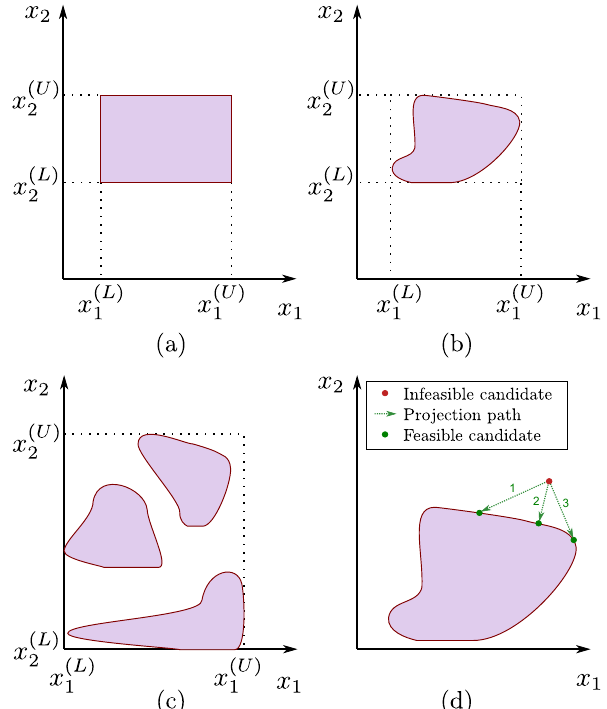
Figure 7. Optimization function bounds: ( a ) simple, ( b ) non-linear, and ( c ) complex. Candidate projection on feasible space ( d